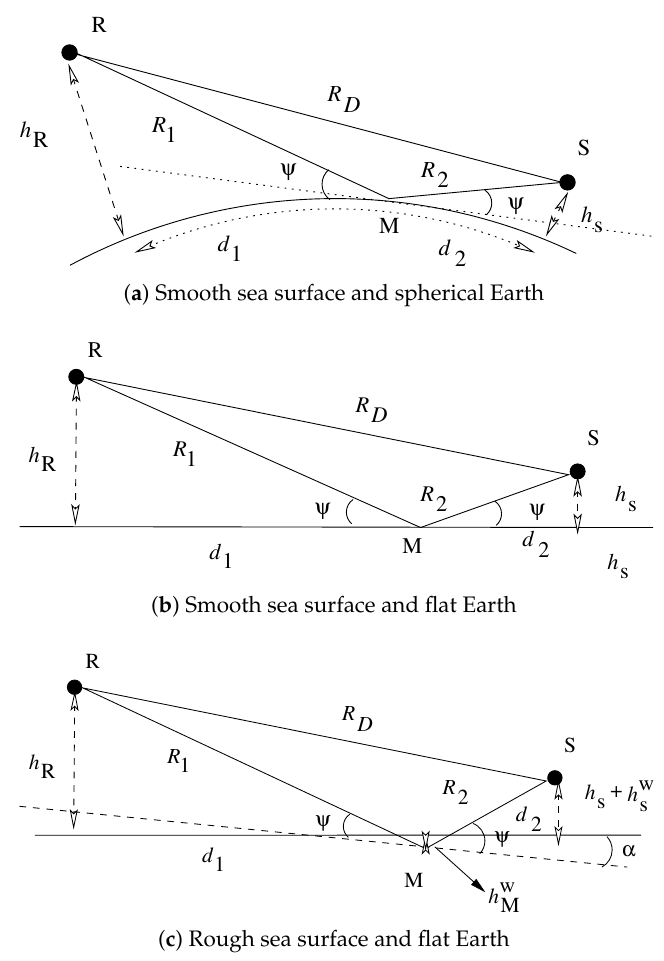
Figure 1. Multipath propagation for different geometry models.